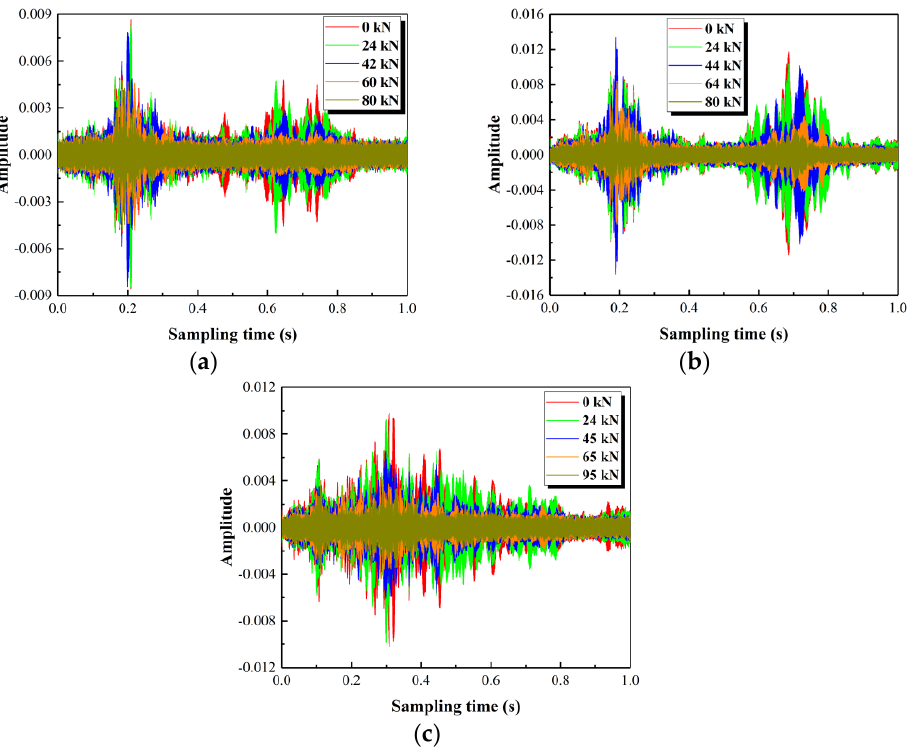
Figure 26. Time-domain signals of the test specimens. ( a ) Test specimen G1; ( b ) Test specimen G3; ( c ) Test specimen S1.